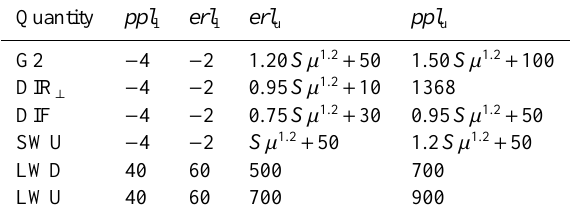
Table 3. Quality checks as defined in the BSRN guidelines. The lower physically possible ( ppl l ) and extremely rare ( erl l ) limits, and the corresponding upper bounds ( ppl u and erl u ) are defined for the following radiative components: (G2) downwelling global shortwave measured by the pyranometer, (DIF) di ff use shortwave, (DIR ⊥ ) direct normal shortwave, (LWD) downwelling longwave, (LWU) upwelling longwave and (SWU) reflected shortwave radi- ations. S is the solar radiative flux at the top of the atmosphere / r 2 S a , being S a = 1368W / m 2 the solar constant at defined by S = r 2 0 the mean earth-sun distance r 0 . µ is the cosine of the solar zenith angle θ . All values in W / m 2 .